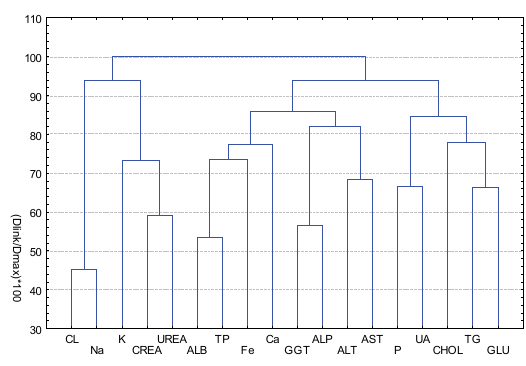
Figure 5. Hierarchical dendrogram of biochemical variables for male (ESRF) patients.